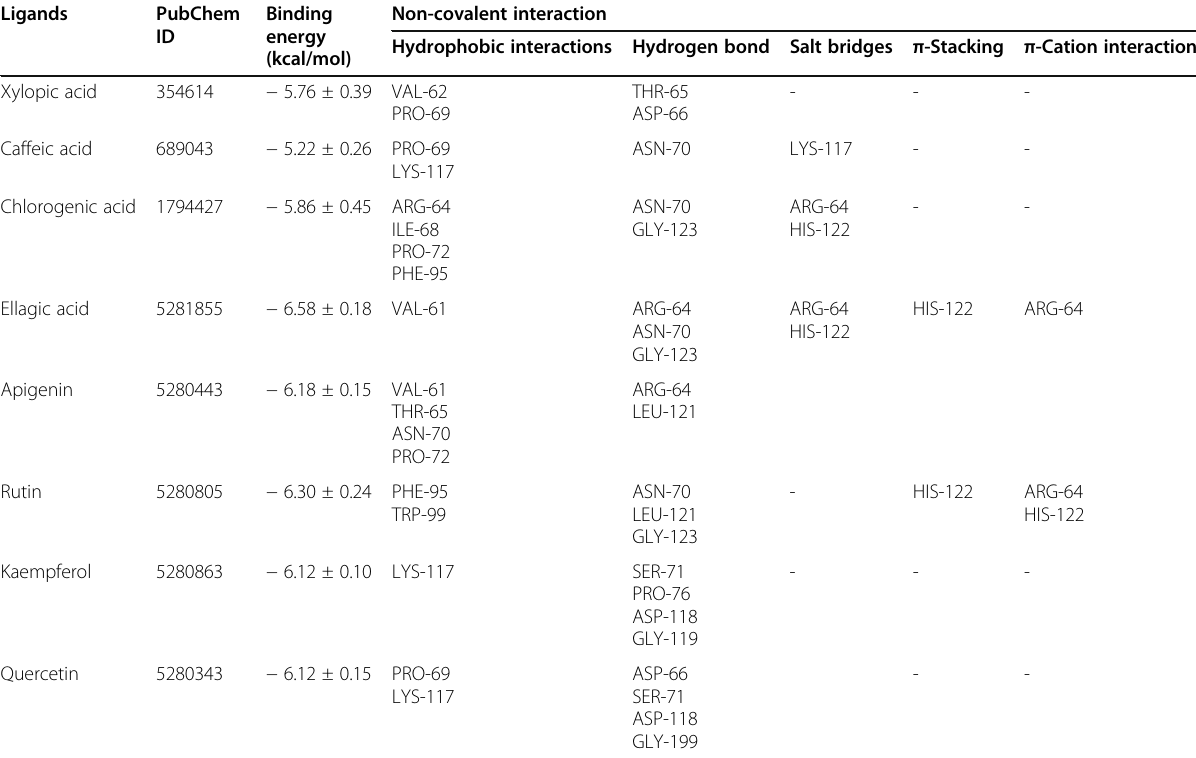
Table 2 Binding energy and non-covalent interaction of TNFL8 with the selected